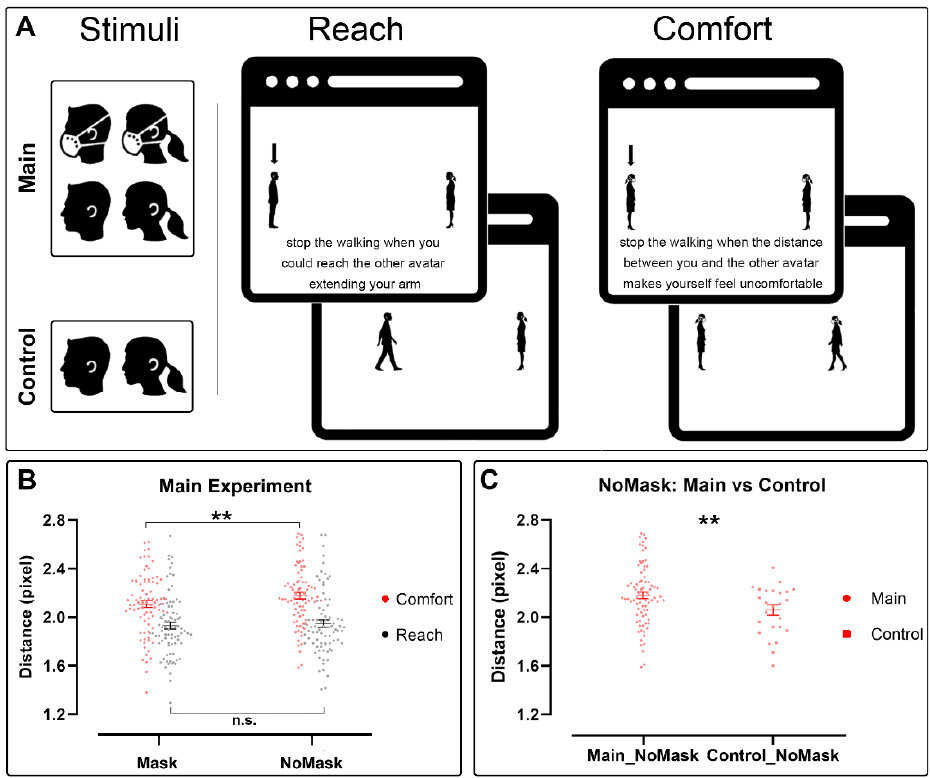
Figure 1. ( A ) Experimental design. Online version of reach-comfort distance estimation task. Sub- jects were asked to identify with the avatar (both male or female avatar, depending on the sex of the participant) indicated by the arrow on the first web page and follow the instruction written